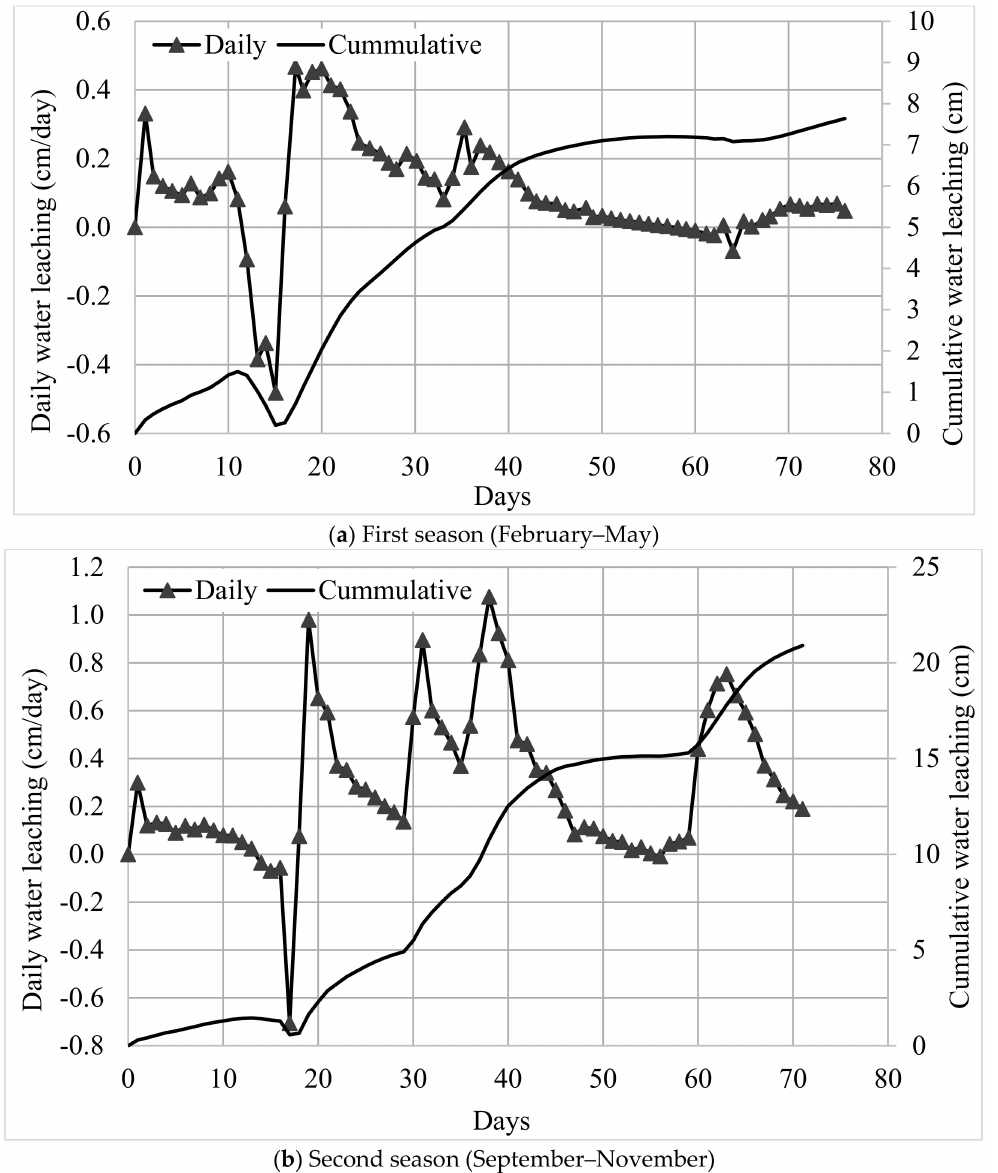
Figure 10. Simulated water leaching losses during two growing